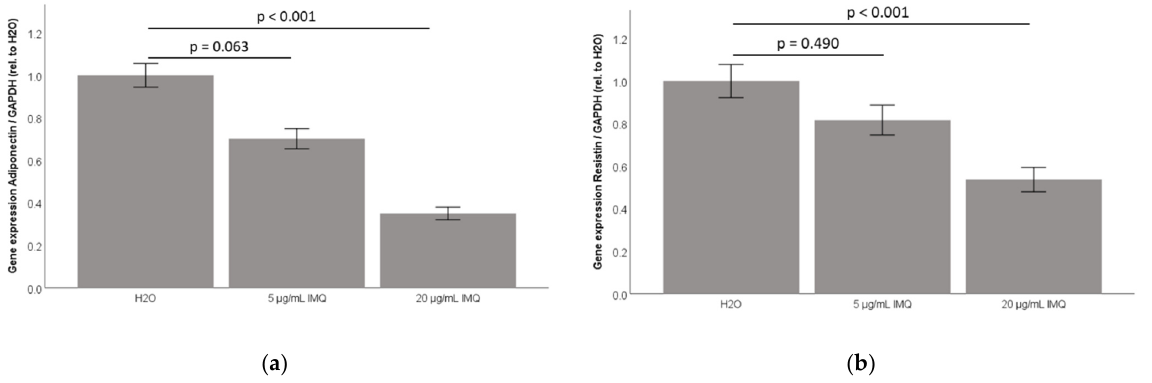
Figure A3. Imiquimod reduces both adiponectin and resistin mRNA levels in 3T3-L1 adipocytes in vitro. Mature 3T3-L1 adipocytes ( n = 11–12 wells each) were treated with different doses of TLR7 agonist imiquimod (IMQ) for 18 h as described in the Materials and Methods section. After isolation of mRNA applying the RNeasy ® Mini Kit (Qiagen, Hilden, Germany), gene expression levels of murine adiponectin and resistin were quantified by reverse transcription and real-time PCR (RT- PCR) of the corresponding cDNA and normalized to GAPDH, as described in the Methods section. Imiquimod reduced both ( a ) adiponectin and ( b ) resistin mRNA levels.